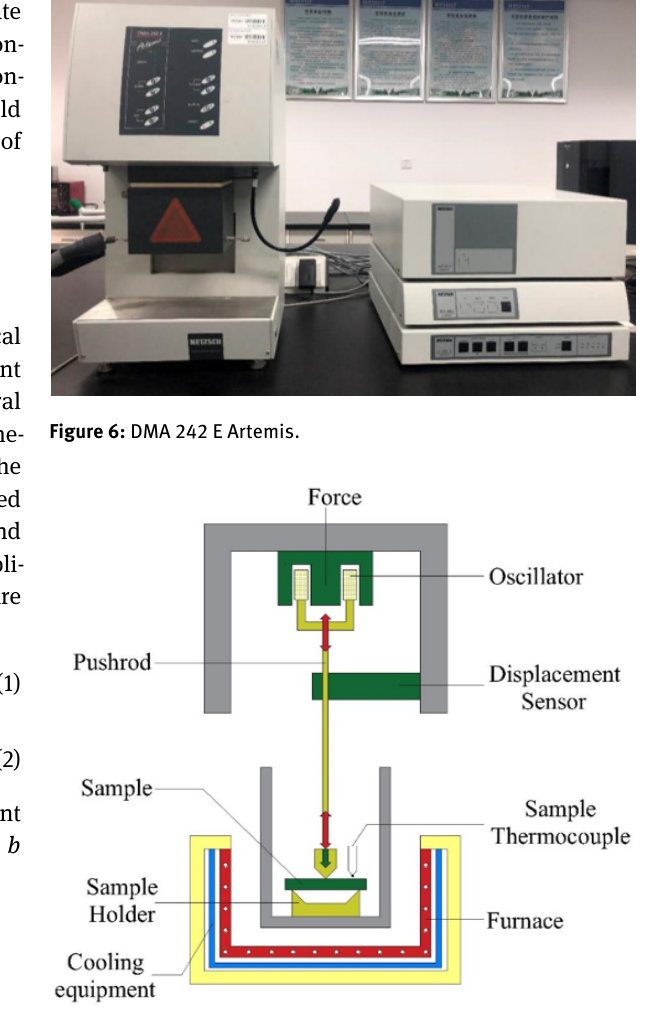
Figure 7: The functional principle of DMA 242 E